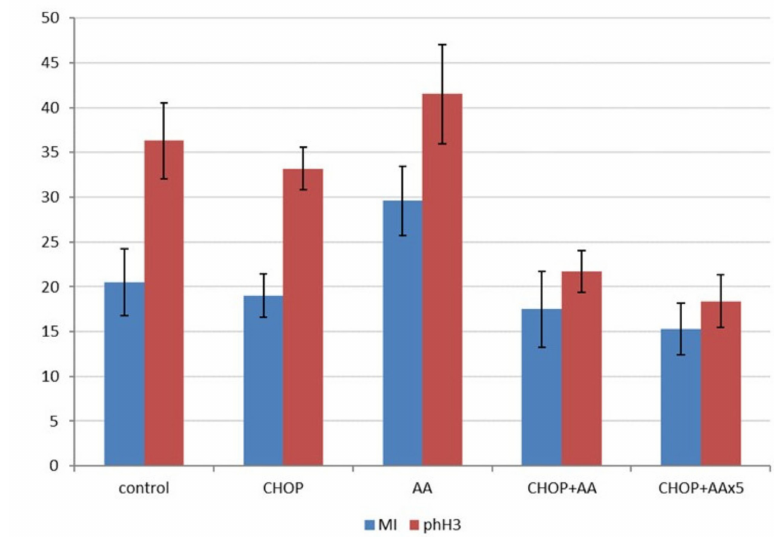
Figure 5. Mitotic index and phospho-histone 3 labeling index in A20 lymphoma treatment groups (y-axis represents mean counts / high-power field). Except of the series of the AA treatment only mild changes were stated when mitosis counting was applied (left columns). phH3 IHC, specifically detecting Ser10 phosphorylated histone3 required for mitotic entry in dividing cells, presented higher mitotic numbers and a statistically significant decrease in cell division activity in the CHOP + AA and CHOP + AAx5 treated tumors (right columns, p <